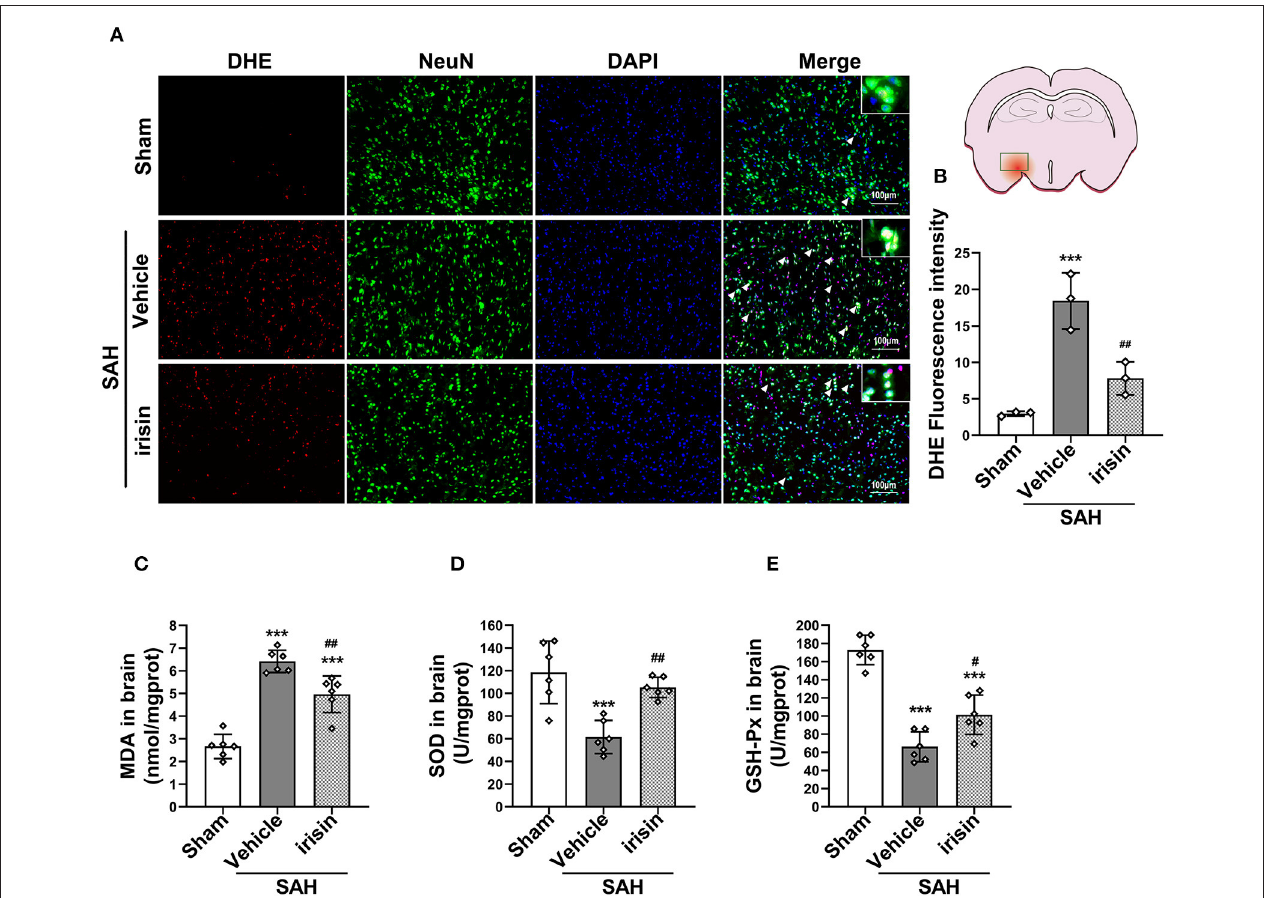
FIGURE 5 | Effect of exogenous irisin treatment on SAH-induced oxidative stress 24h after SAH. (A,B) A lower red fluorescence intensity (DHE) was observed in the irisin-intervened group, Scale bar = 100 µ m, n = 3 for each group. (C) Levels of oxidative markers were analyzed, MDA levels were significantly decreased after irisin treatment. (D,E) SOD and GSH-PX levels were increased with the irisin intervention, n = 6 for each group. Data were presented as mean ± SD. The one-way ANOVA was used followed by the Tukey’s HSD post-hoc test and the Holm–Bonferroni correction method. *** P < 0.001 vs. Sham group; # P < 0.05, ## P < 0.01 vs. SAH + Vehicle group. Vehicle, sterile 0.9% of NaCl; DHE, dihydroethidium; SOD, Superoxide Dismutase; GSH-PX, Glutathione Peroxidase